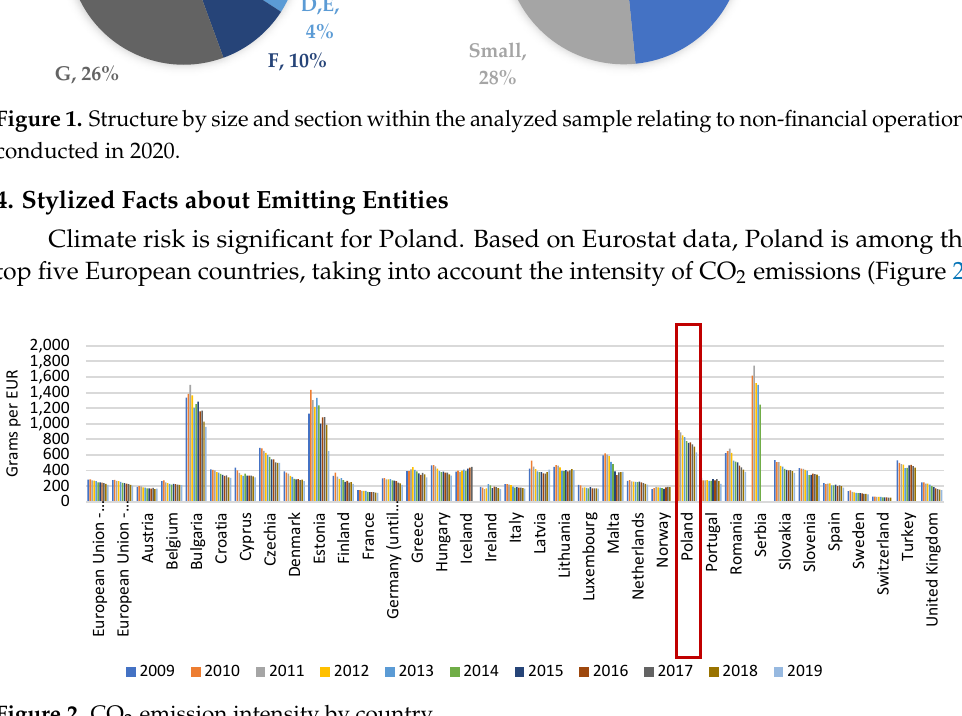
Figure 2. CO 2 emission intensity by country.